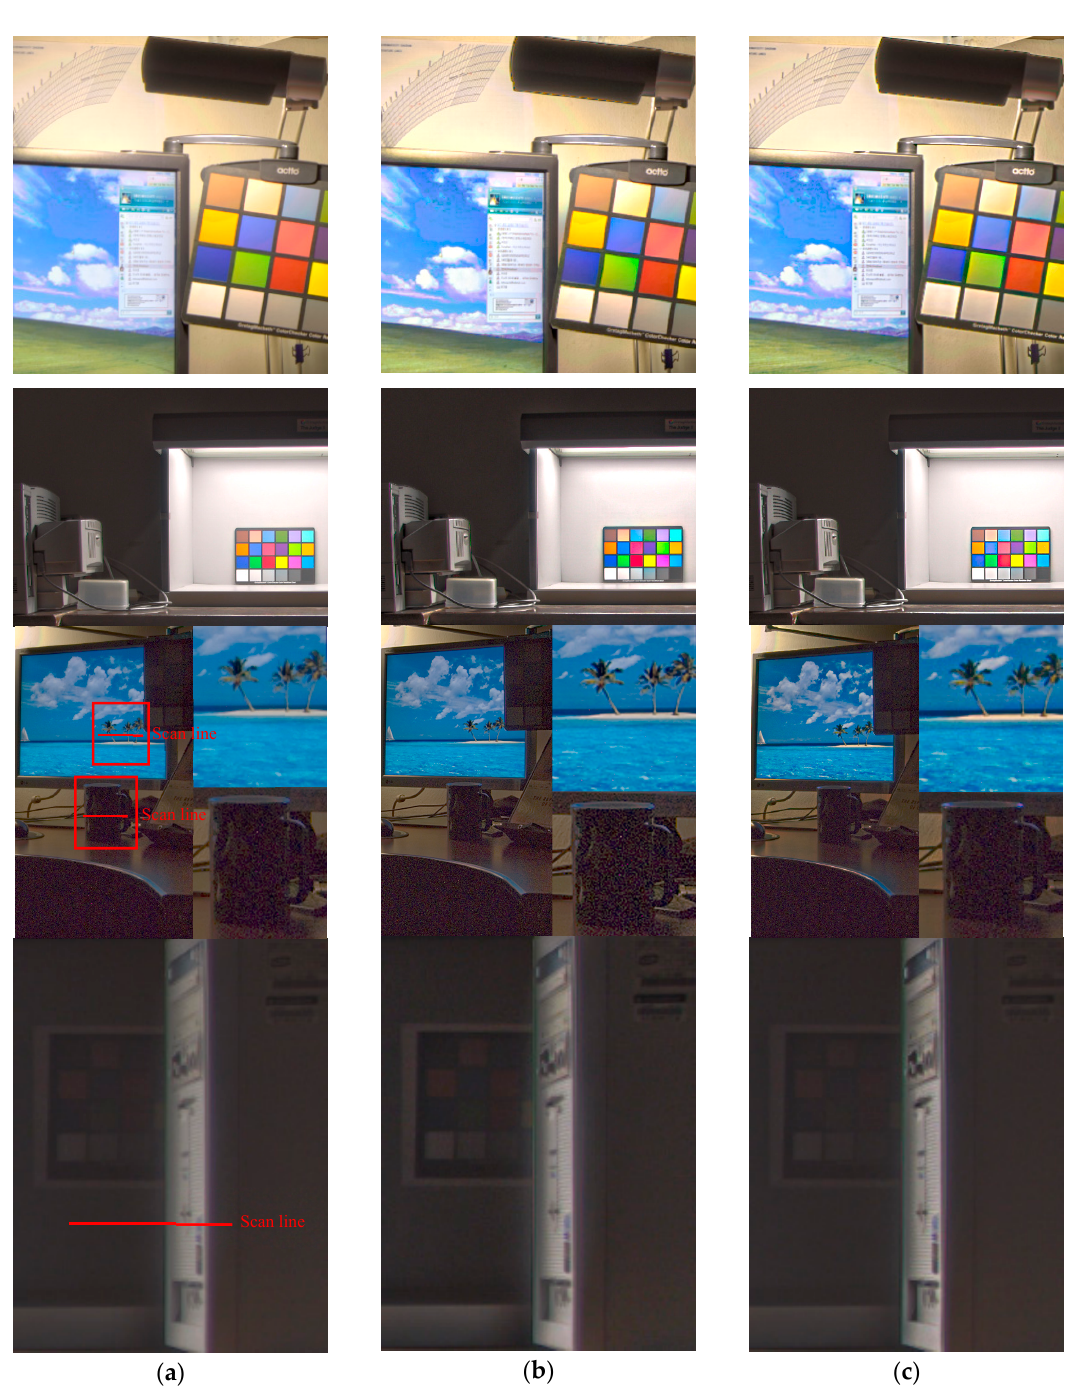
Figure 6. Comparison of detail rendering performance for each method. High dynamic range (HDR) rendered image by ( a ) Stevens adjustment, ( b ) Stevens adjustment with the global CSF gain and ( c ) the proposed method.